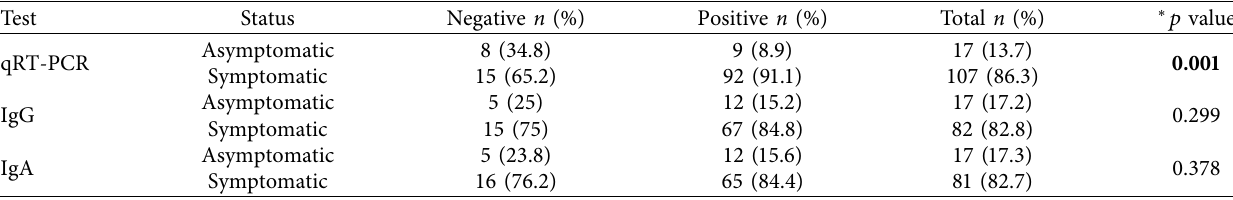
Table 3: SARS-CoV-2 infection among 124 children and adolescents according to their symptom status. Test